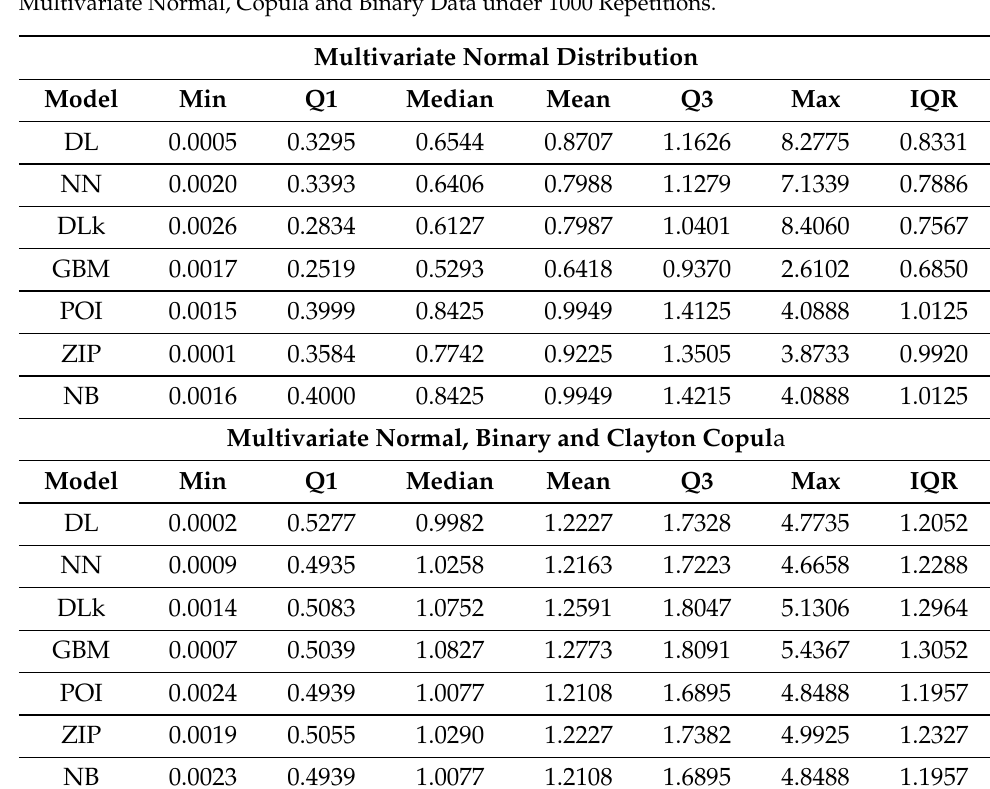
Table 1. RMSE of Simulated Multivariate Normal Data and Non-Normal Combined Data with Multivariate Normal, Copula and Binary Data under 1000